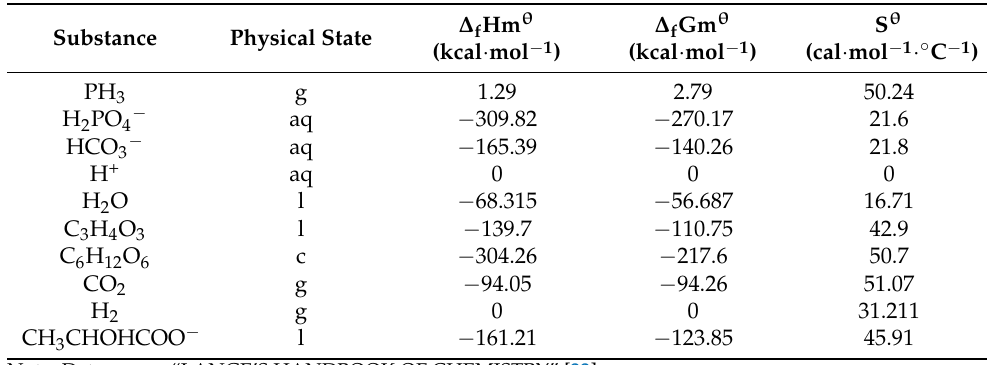
Table 5. Thermodynamic properties table.